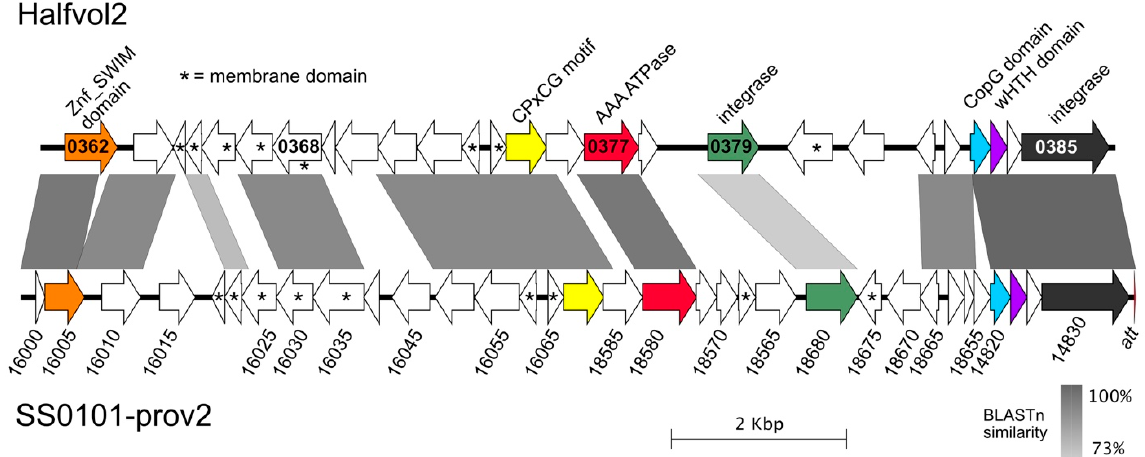
Figure 8. Comparison of Halfvol2 with a closely related provirus of Hfx. volcanii strain SS0101. Locus tag numbers are given inside gene arrows for Halfvol2 without the prefix (HVO_). The Hfx. volcanii SS0101-prov2 region was assembled from the following (overlapping) contigs: NZ_VMTR01000276, NZ_VMTR01000271, NZ_VMTR01000159 and NZ_VMTR01000131. Locus tag numbers are given below gene arrows but without their prefix (FQA18_). Asterisks denote encoded proteins predicted to contain transmembrane domains (Phobius/TMPred).